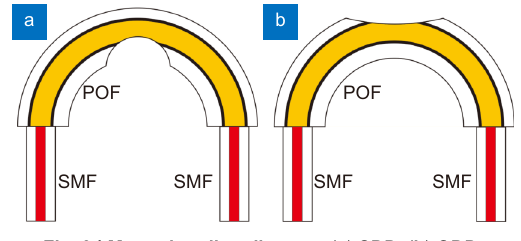
Fig. 9 | Macro-bending diagram. ( a ) SDB. ( b ) ODB.